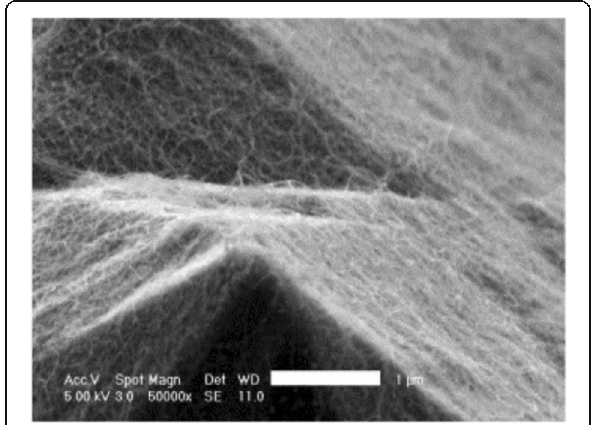
Fig. 27 Schematic of a catalyst patterning technique which involves the control of growth direction of CNTs by partially patterning the catalyst layer on slanted KOH-etched edges. The corresponding SEM image of CNT pillars grown on the pyramid inside the KOH-etched microchannel is shown. Adapted from